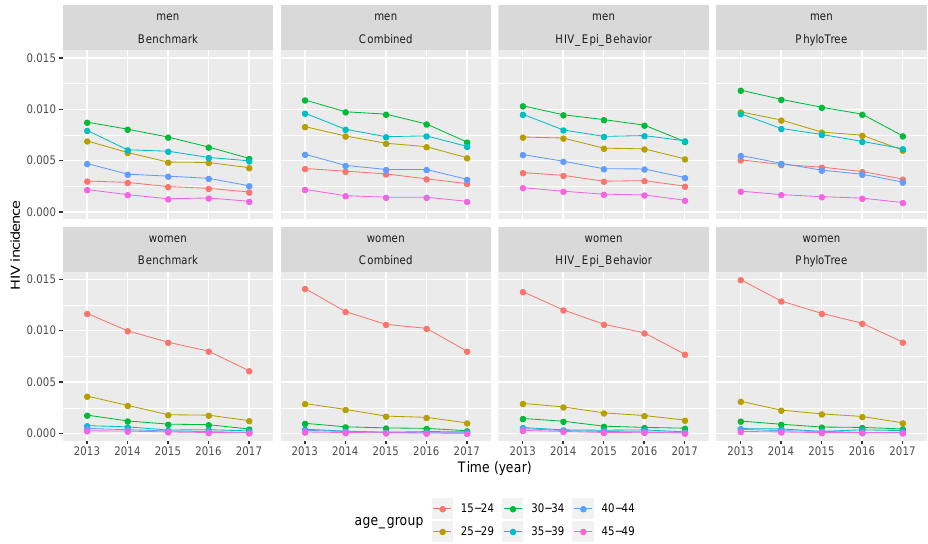
Figure 5. Temporal trends of HIV incidence produced by median values of retained parameter values. Incidence values in different age groups from benchmark data and after calibration when the simulation was performed by median values of the retained parameters. (Combined features—2nd column, epidemiological and behavioural features—3rd column, and phylogenetic features—4th